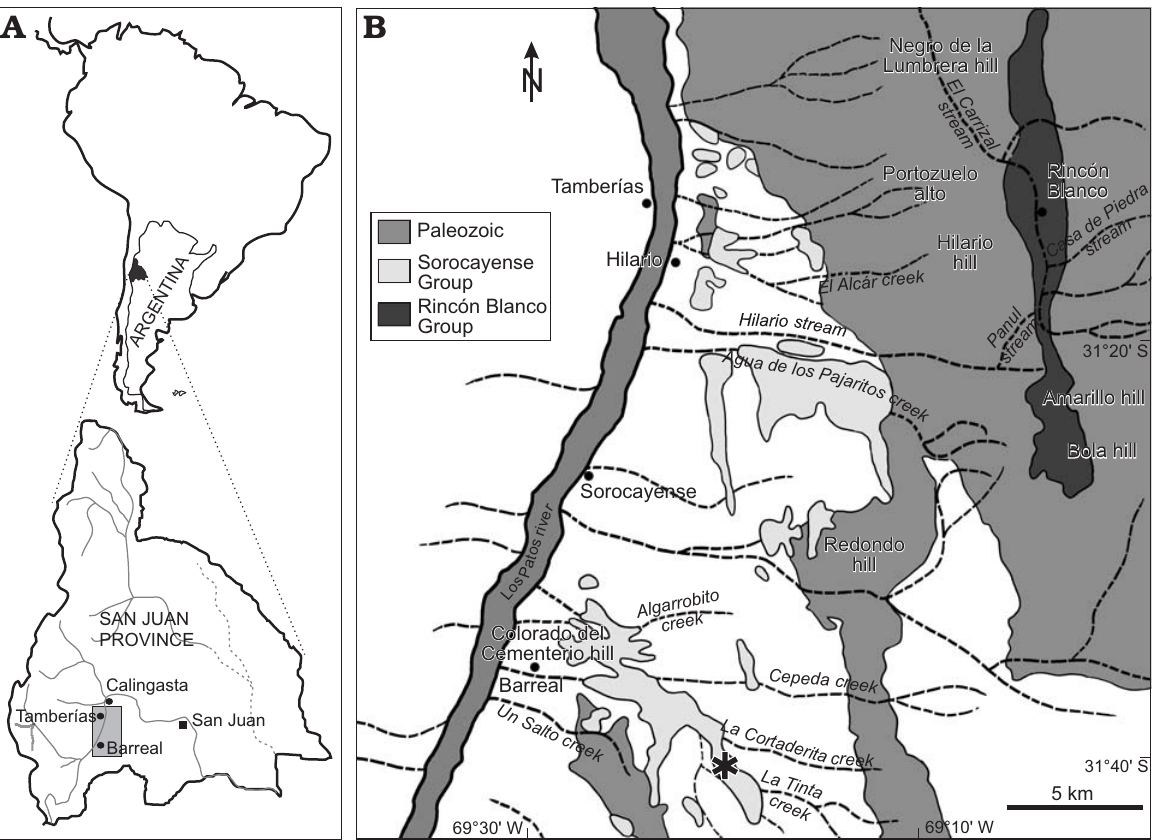
Fig. 1. A . Geographic location of study area at San Juan Province, Argentina. C . Geologic map showing the sampled locality (asterisk) at Cortaderita and La Tinta creeks, near Barreal town. Taken from Bodnar et al.